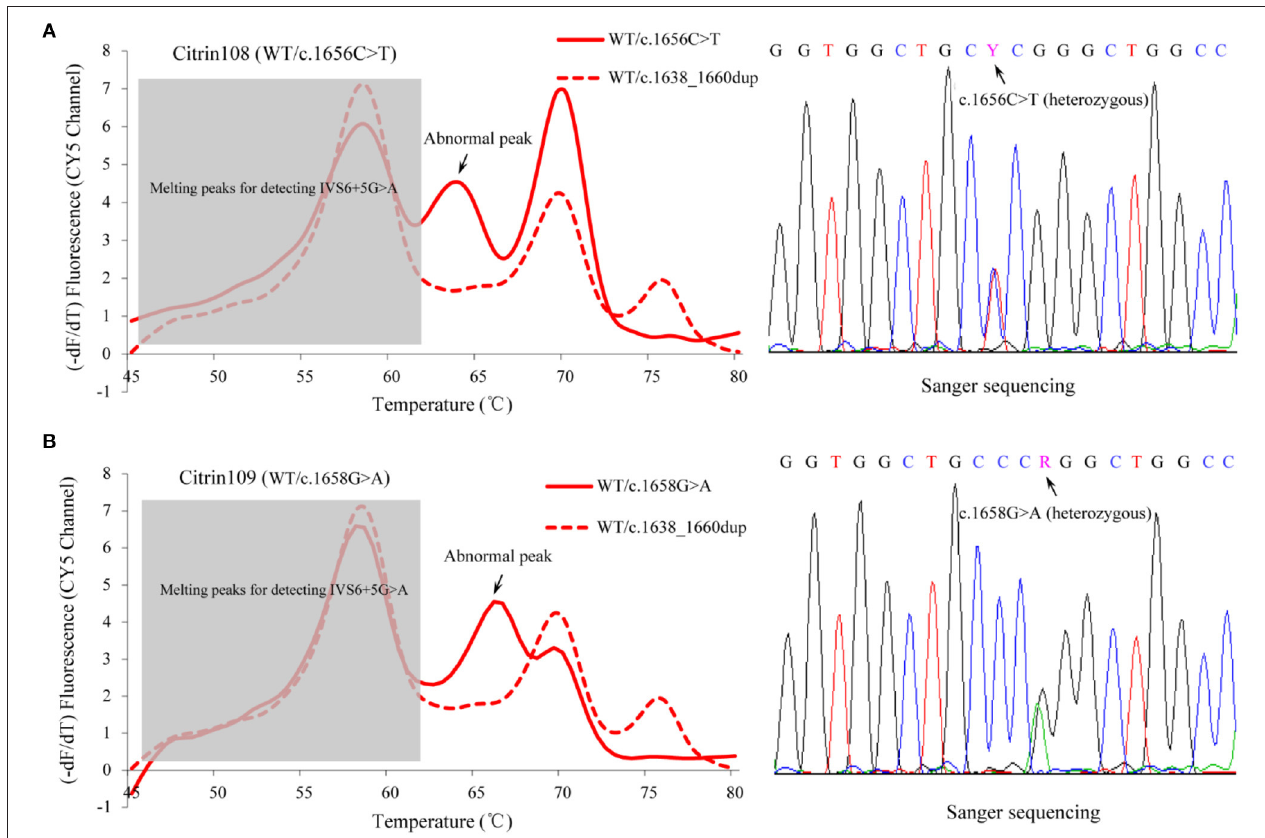
FIGURE 4 | Abnormal fluorescence melting peaks in the MMCA assay. MMCA genotyping of the SLC25A13 c.1638_1660dup mutation displayed abnormal melting peaks with unexpected melting temperature values in three screening samples, and Sanger sequencing of the probe region uncovered one sample carrying (A) heterozygous c.1656C > T mutation and (B) two others carrying heterozygous c.1658G > A mutation (one representative is shown). Melting curves are only displayed in the CY5 channel, and the abnormal melting peaks are marked in the solid lines that correspond to the melting curves of the screened samples. The dashed line represents the melting curve of WT/ c.1638_1660dup genotype, indicating the positions of normal melting peaks. –dF/dT, the negative derivative of fluorescence over temperature; WT, wild-type; MMCA, multicolor melting curve